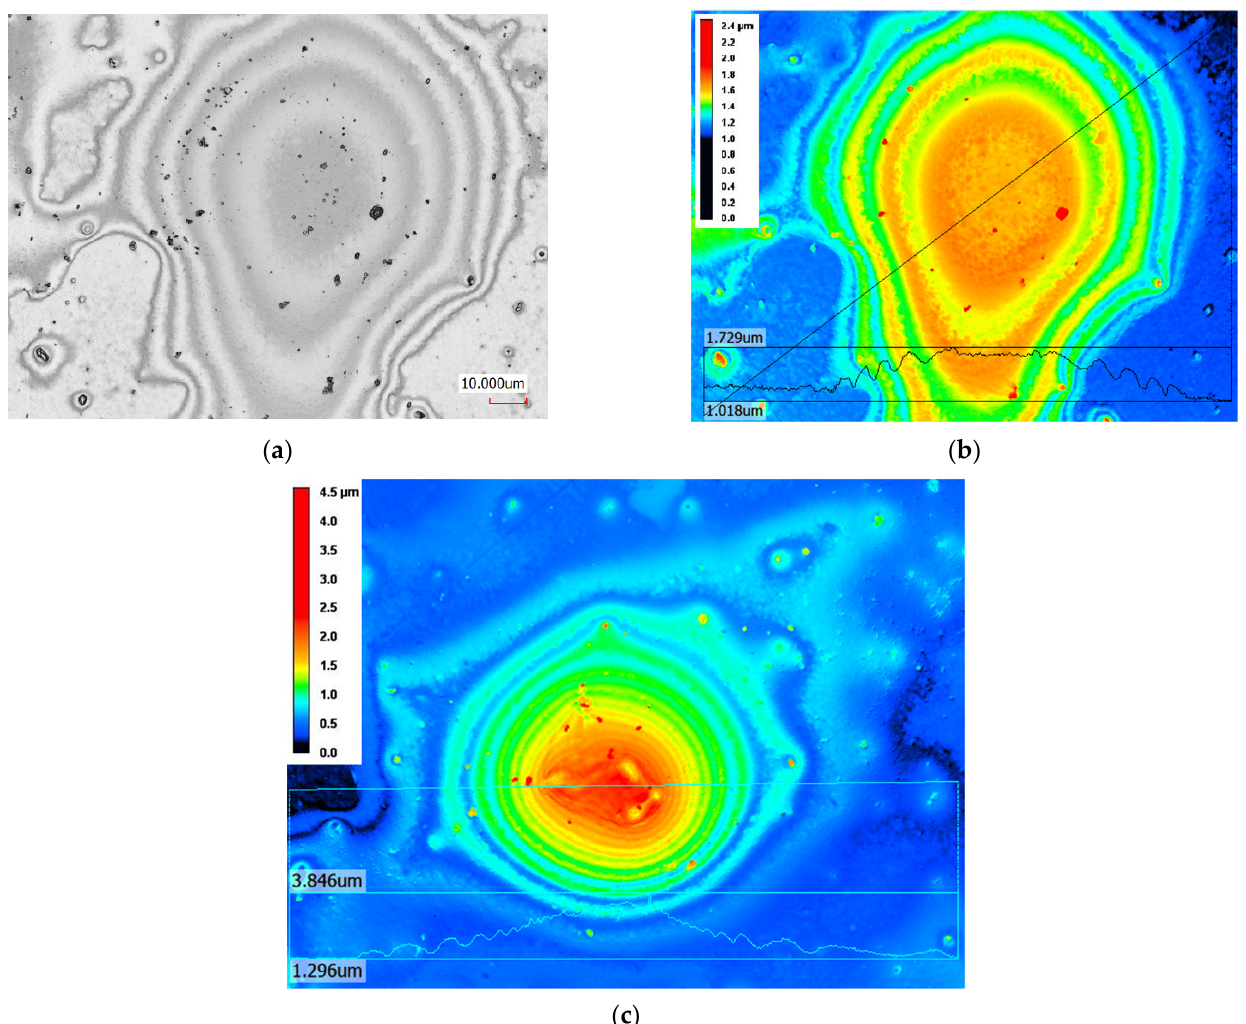
Figure 8. Surface and map with profile of the protuberance W–Zr–B film after delamination from steel substrate 0.3-mm thick with a laser pulse energy of 1 J and duration of 10 ns. ( a ) Surface image after layer delamination; ( b ) contour map and profile of the protuberance; and ( c )contour map and profile of protuberance in the next sample delaminated at the same condition.